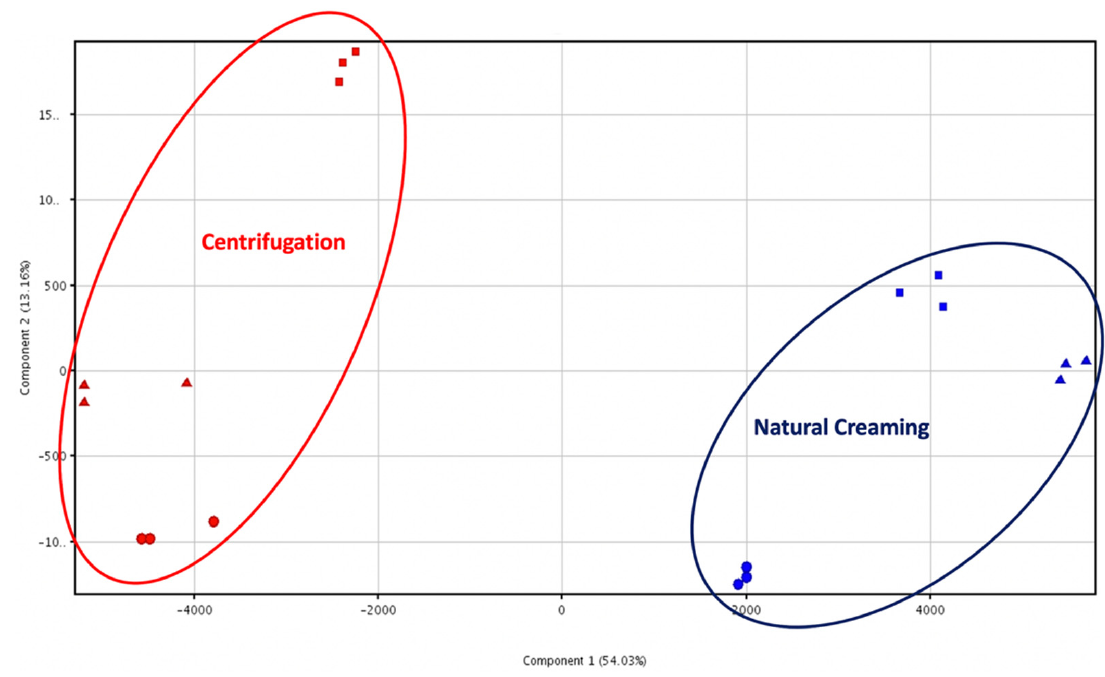
Figure 2. Unsupervised principal component analysis (PCA) considering the different separation technique (i.e., centrifugation vs. natural creaming). The individual sample replications (n = 3) are provided into the PCA score plot.